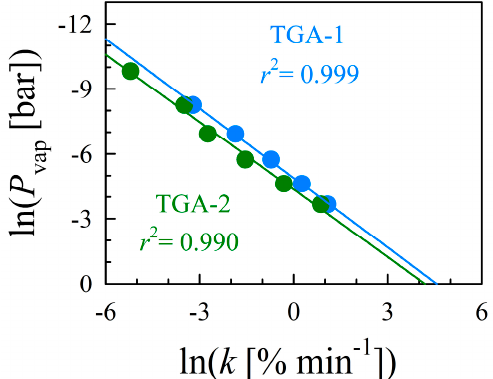
Figure 2. The linear relationship between the natural logs of both the evaporation rates of glycerol and their corresponding P vap as reported in the literature [37,39]. The theoretical line is obtained by fitting the data to Equation (1) with r 2 = 0.995. Coefficients a and b represent the constants of Equation (1), which are dependent on the instrument and operational parameters. (A) TGA-1 (B) TGA-2.